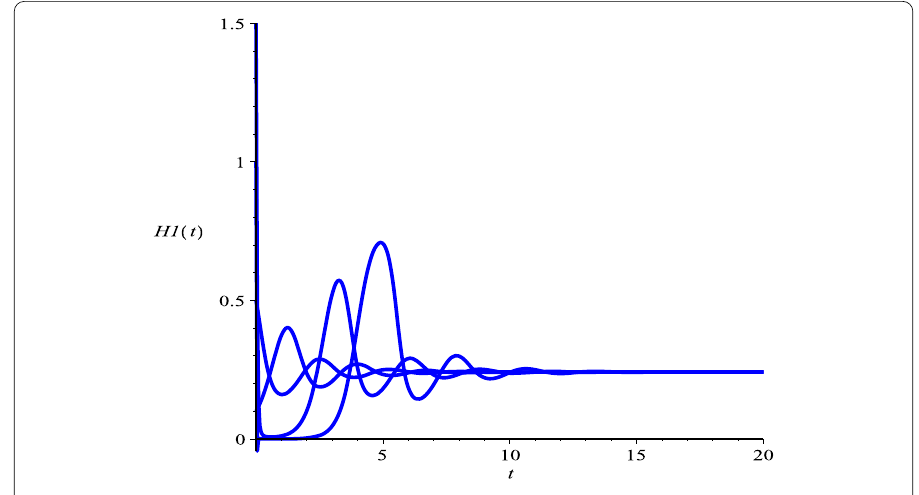
Figure 7 Dynamic behaviors of the strong partners in system (5.6). The initial conditions ( H 1 (0), H 2 (0), P (0)) = (1,2,0.7),(1.5,1,0.3),(0.5,0.2,0.1), and (0.1,0.1,2),